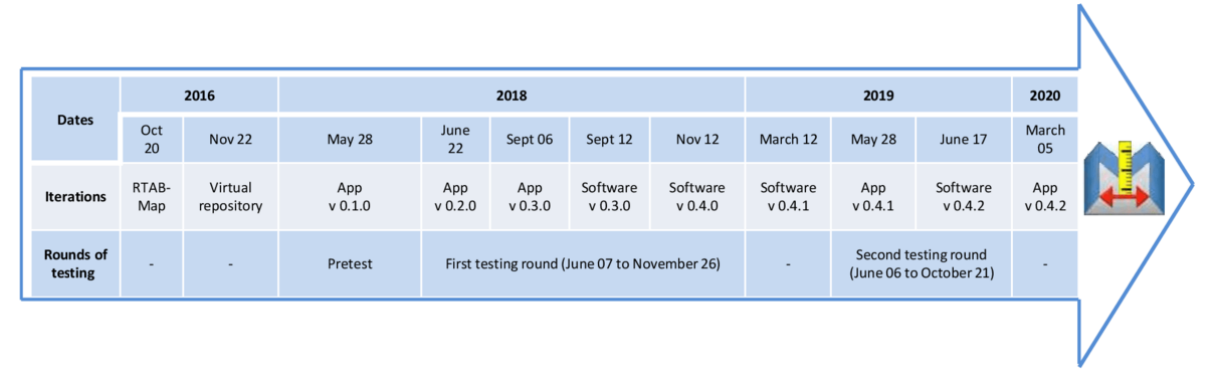
Figure 1. MapIt’s design process (Notes: The numbered iterations of the prototype are placed chronologically and associated to the corresponding study phase. Some version numbers are skipped to match app and software version numbers; Version 0.4.2 of the app has not yet been tested).